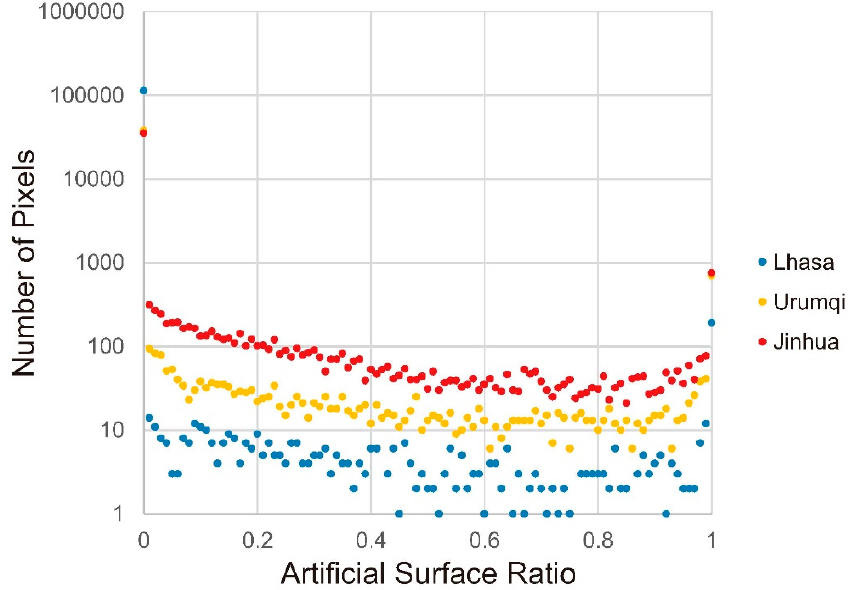
Figure 5. Numbers of pixels in each artificial surface ratio (ASR) interval for Lhasa, Urumqi, and Jinhua.